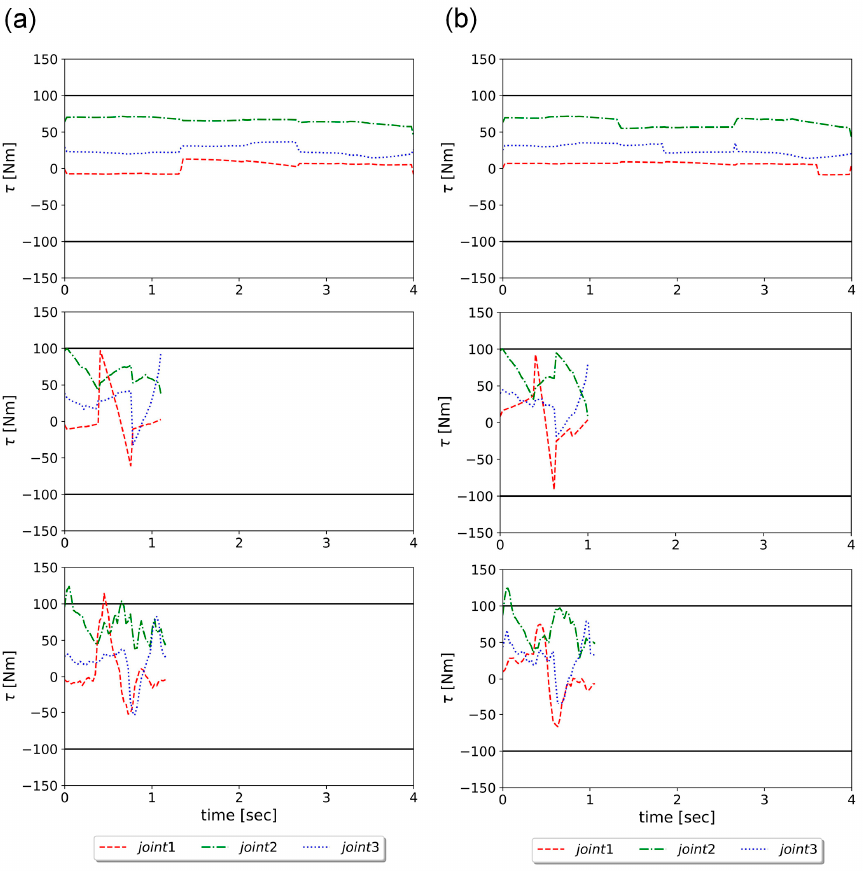
Figure 13. The speed optimization results. From the top: the joint torque profiles of the hybrid model before (1st row) and after (2nd row) speed optimization and of the manipulator (3rd row). The profiles shown in ( a , b ) were optimized from different energy-optimized trajectories: ( a ) using Bi-RRT generated via points and ( b ) using human-taught via points. All plots were drawn using Python and Matplotlib.